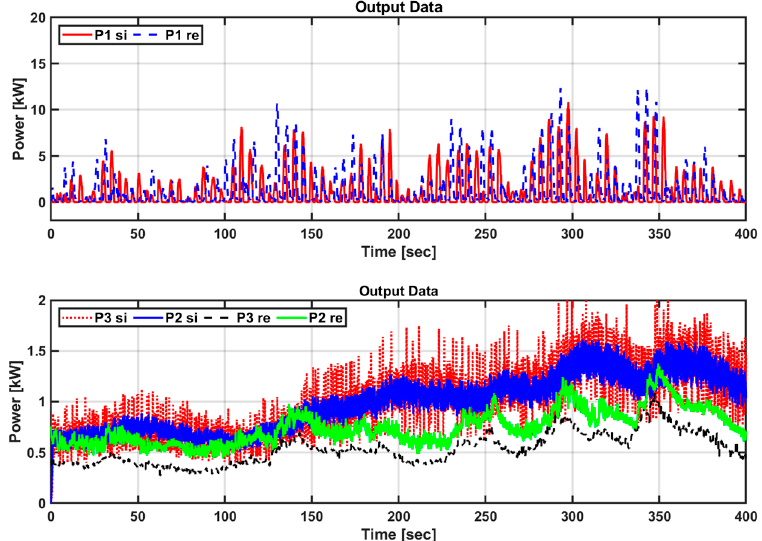
Figure 29. Comparison of the amounts of power generated in the actual sea test and with the speed control algorithm based on the P&O algorithm of the simulator.